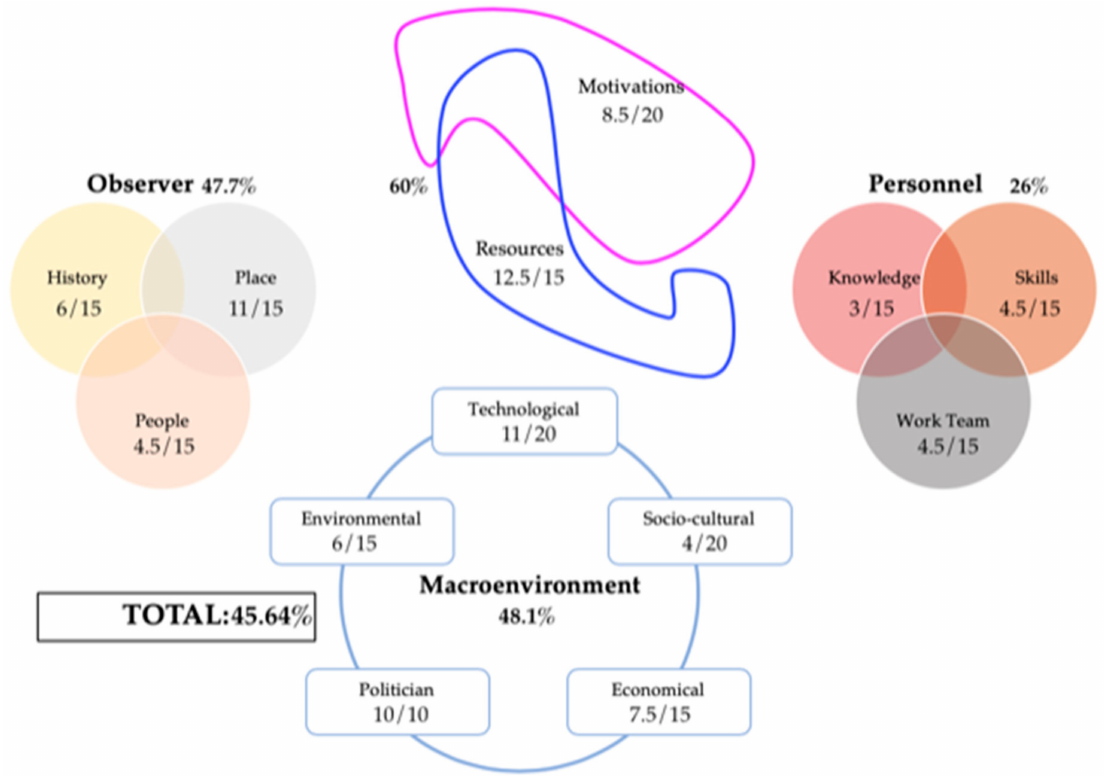
Figure 3. BOT analysis results. Source: Own elaboration based on slideshare.net Á lvaro